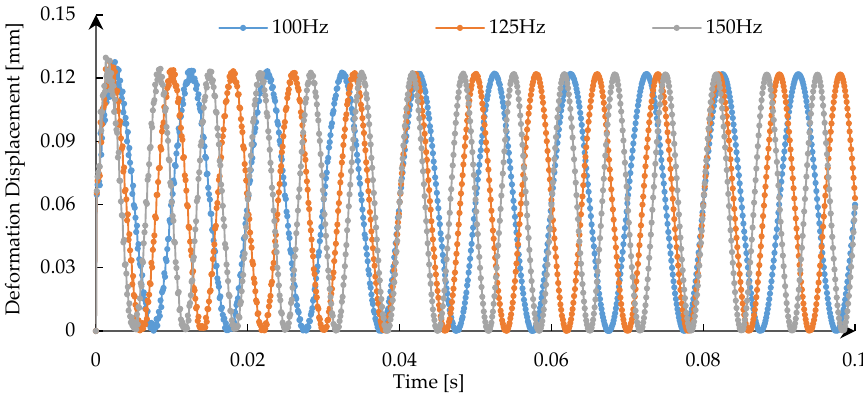
Figure 9. Numerical results showing deformation displacement versus time relationships of the rock for cylindrical indenter under static-dynamic loads with different frequencies of dynamic load.